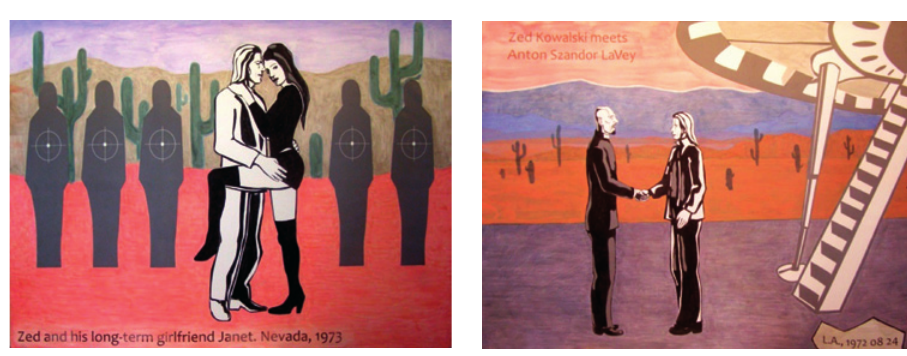
Fig. 1. Konstantinas Gaitanži. Zed and his long- term girl-friend Janet, Nevada, 1973 (2008–2010)